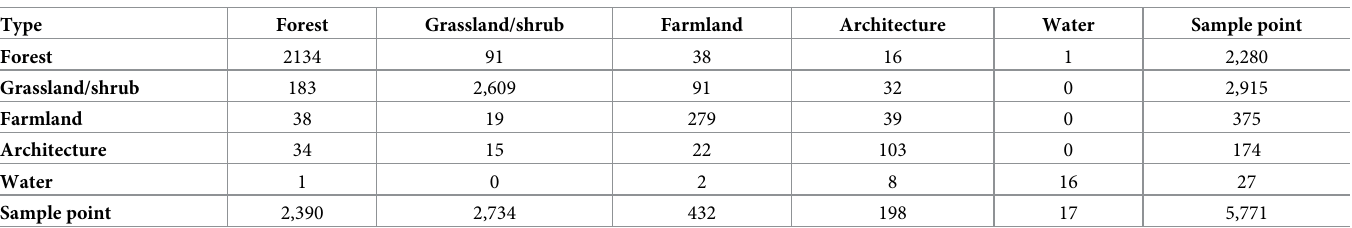
Table 7. Confusion matrix for object-oriented classification of Yugu